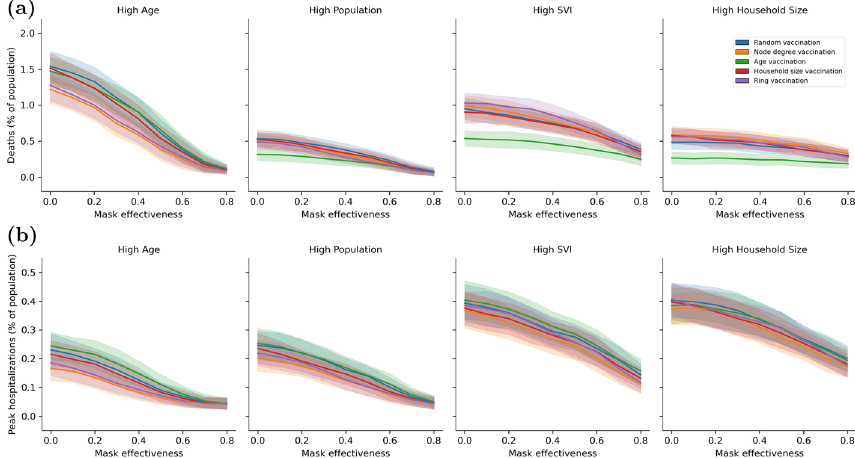
Fig. 10 Impact of mask effectiveness and vaccine strategies on a deaths and b peak hospitalization using Scenario 1 where vaccine willingness is moderately